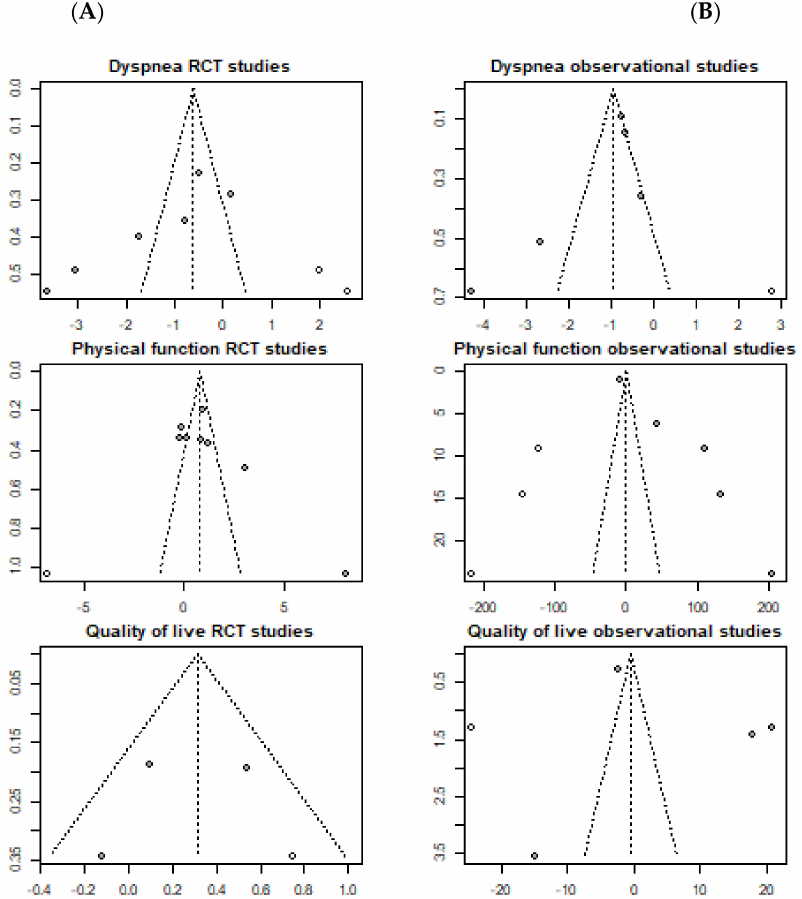
Figure 6. Publication bias of included studies on the effect of Pulmonary Rehabilitation in post-acute patients with COVID-19 related to physical function, dyspnea, and quality of life. ( A ) RCTs assessed; ( B ) Observational studies